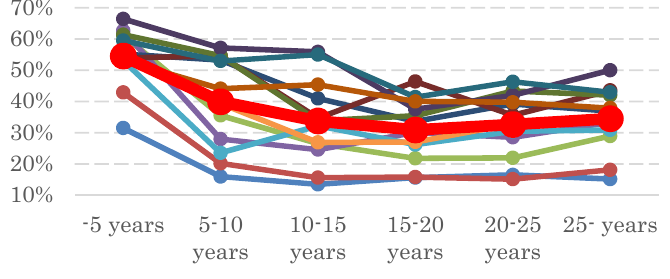
Figure 6. Years of service and “yes” percentage of P5